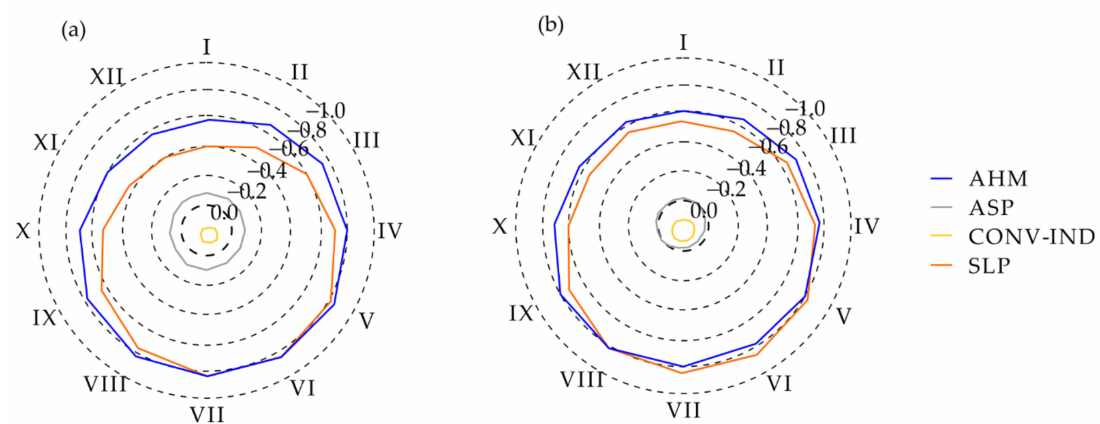
Figure 15. The annual course of the values of the probability index between the parameters supplying the model (AHM, ASP, CONV-IND, SLP) and the average monthly values of global solar radiation [in kWh · m − 2 ] for Cieplice ( a ) and Kołobrzeg ( b